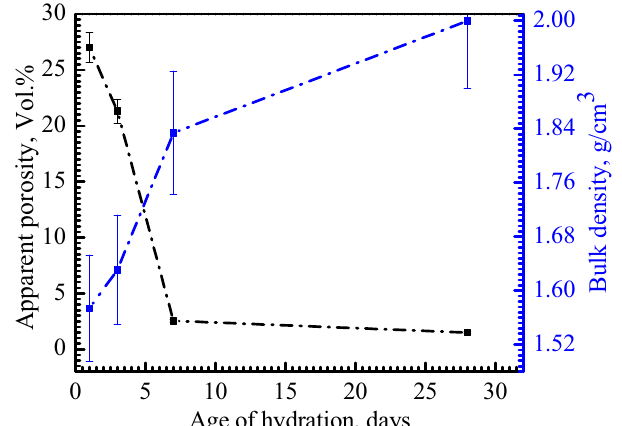
Figure 9. Bulk density and apparent porosity of the hydrated CA60 cement samples sintered at 1450 °C after (1, 3, 7, and 28 days).